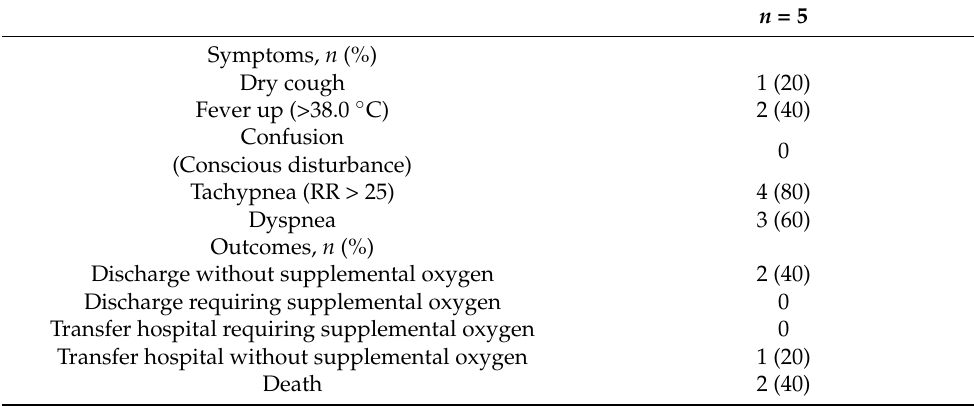
Table 4. Details of patients who could not sustain prone